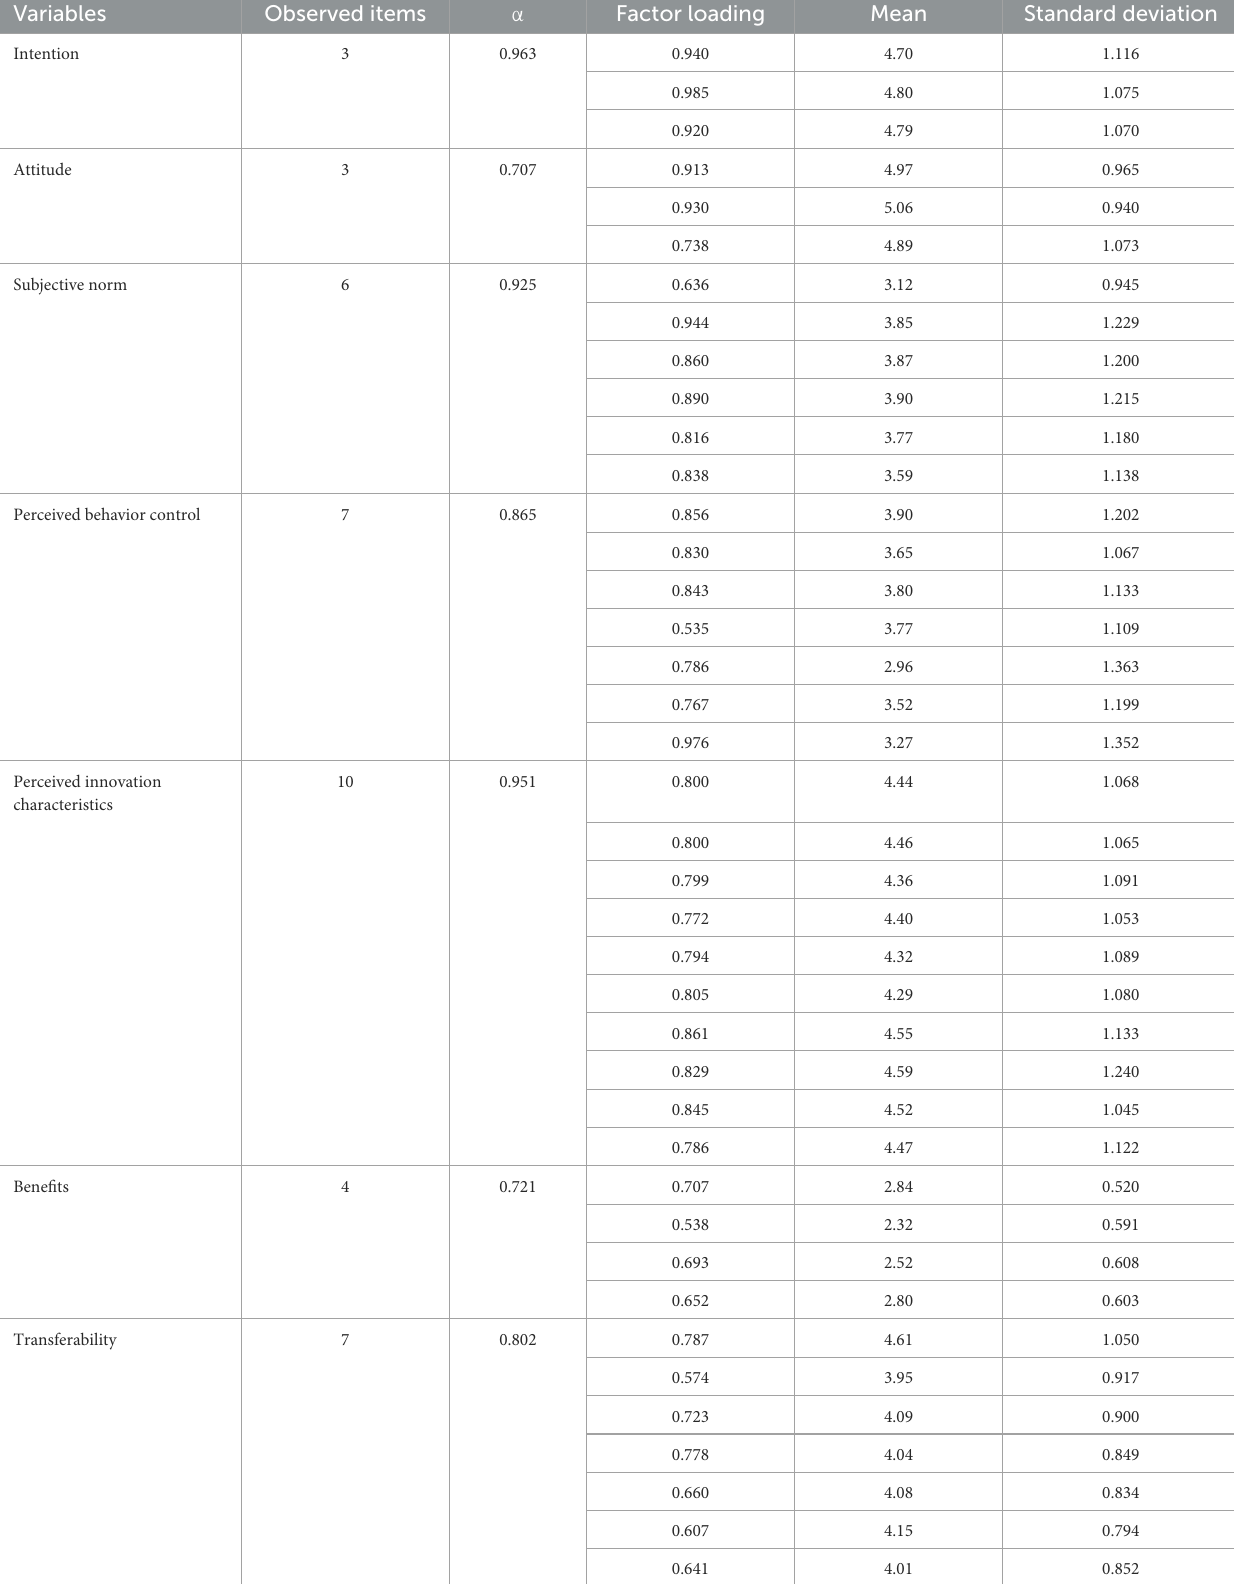
TABLE 2 Reliability, factor loading, mean and SD ∗